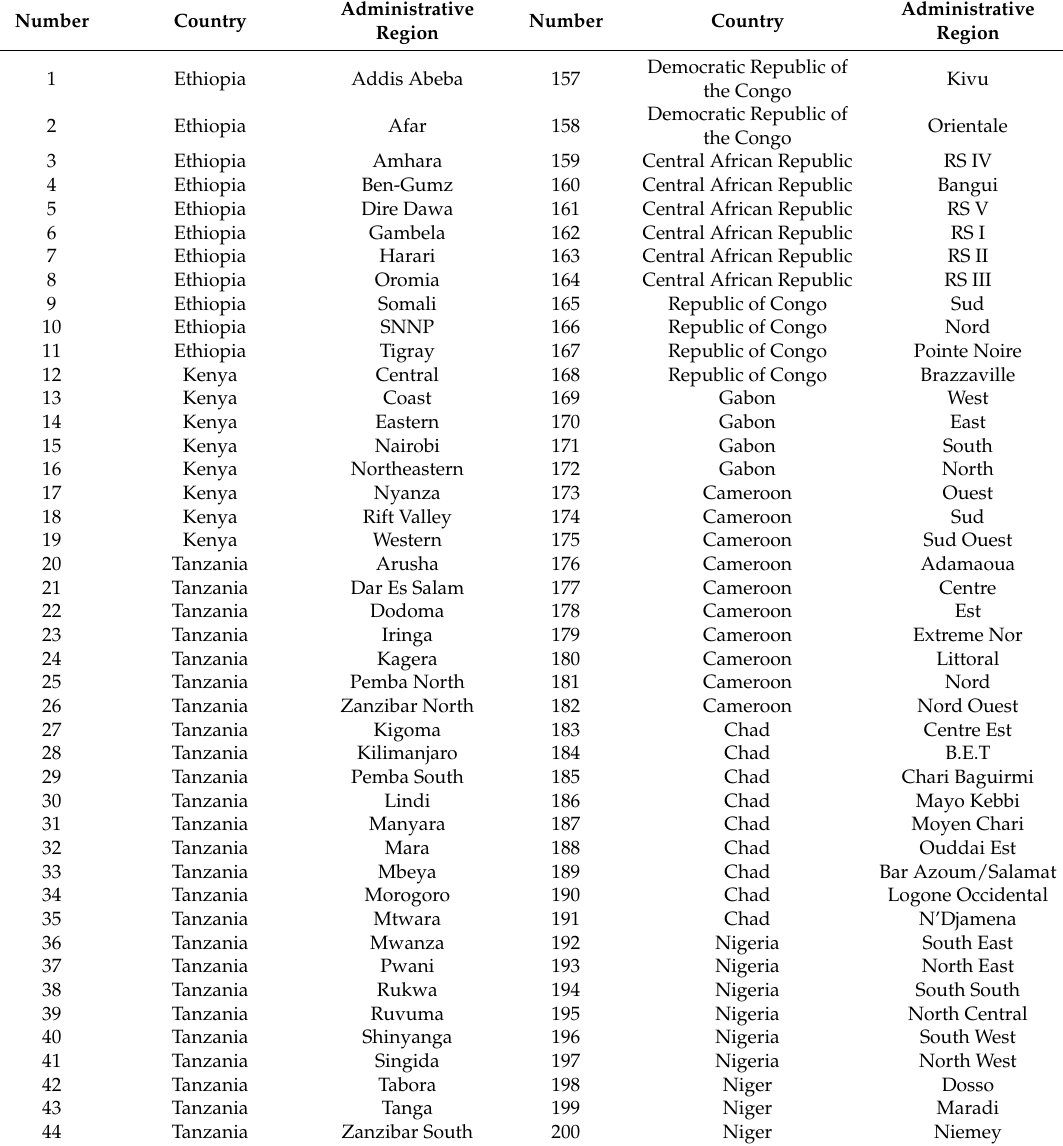
Table A1. Administrative regions within countries under